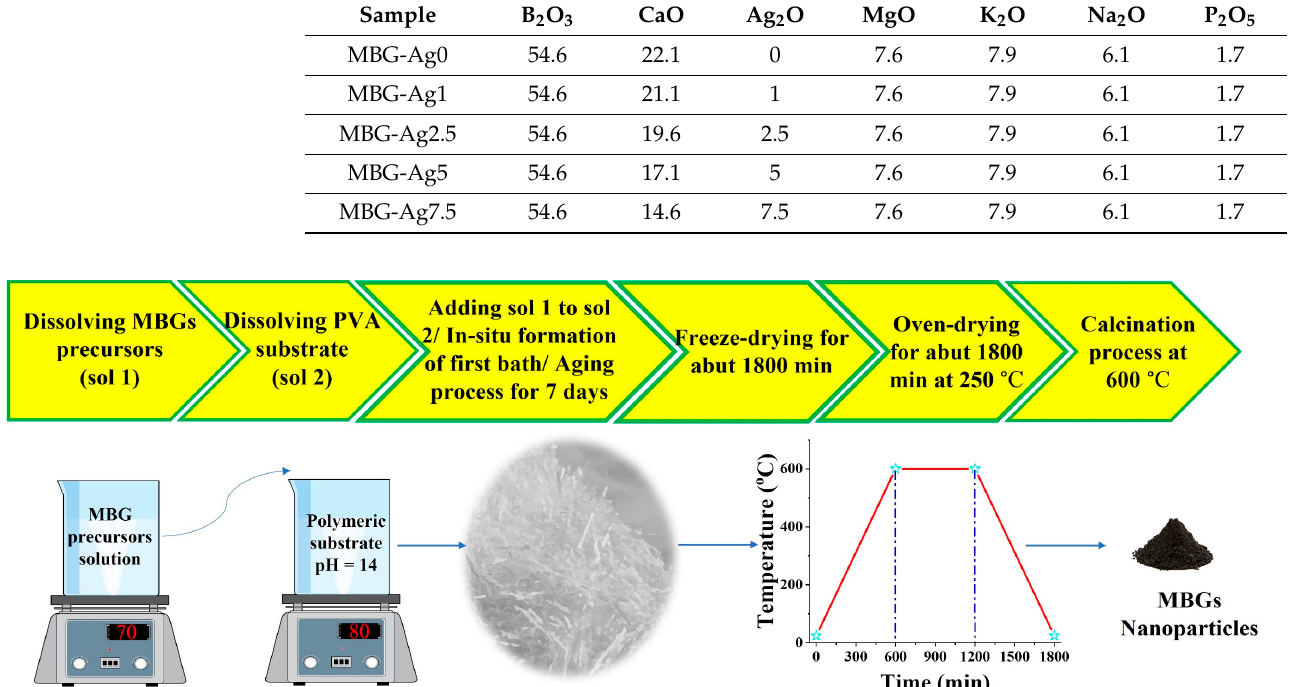
Table 1. Nominal compositions of the Ag-doped 1393B3 MBGs (mol.%).